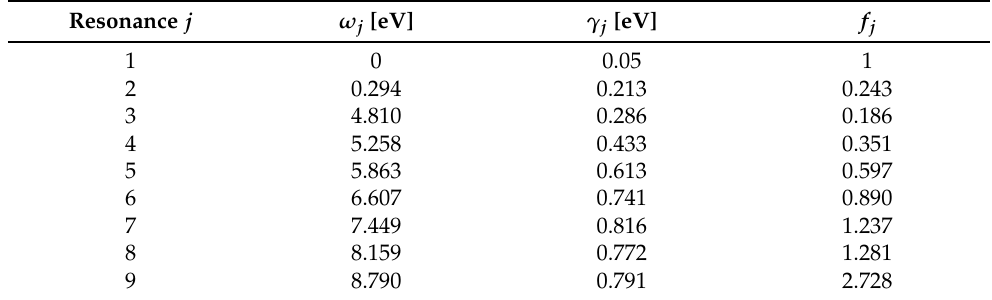
Table 1. The optical parameters of Drude–Lorentz model for AZO6 obtained from DFT-GGA calcula- tions [47].